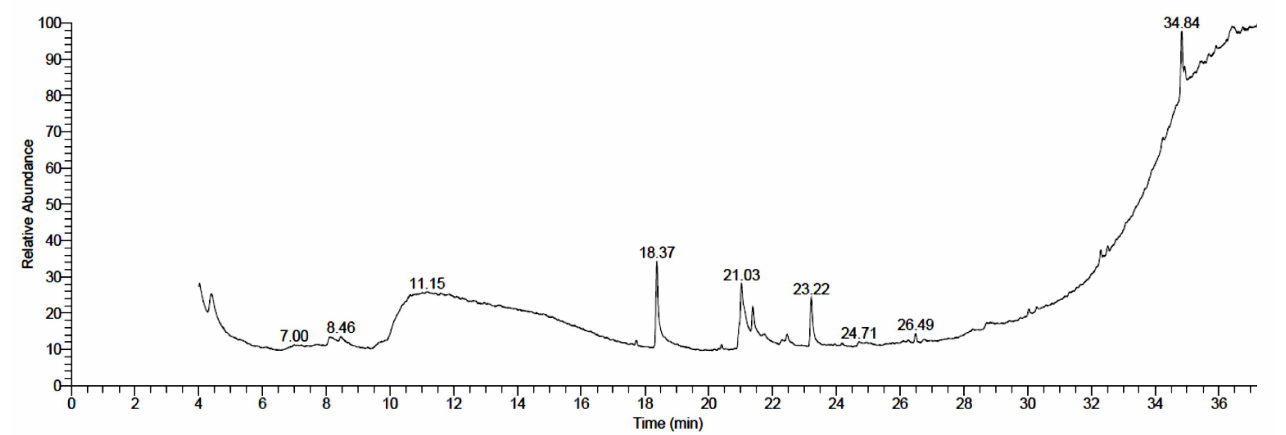
Figure 1. GC–MS chromatogram of Balanites aegyptiaca fruit